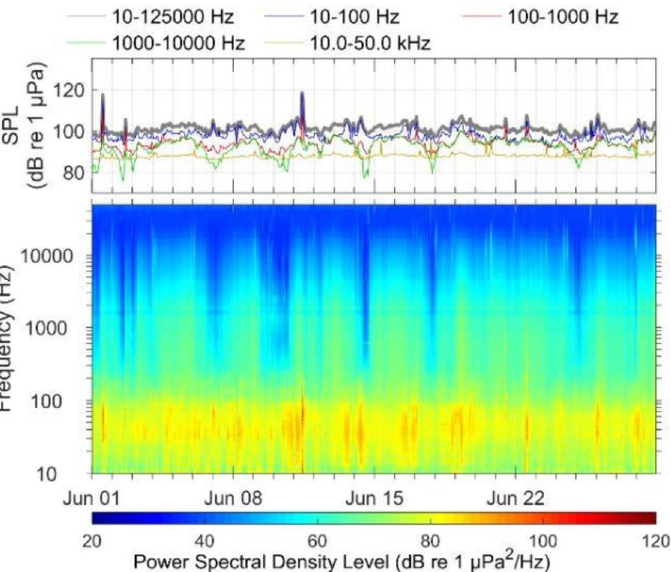
Figure 2. In-band SPL ( top ) and spectrogram ( bottom ) of underwater sound in June 2016 at Moor- ing 6 (reproduced from ObSERVE Programme Report [26], with permission from Department of Communication, Climate Action and Environment, 2018).